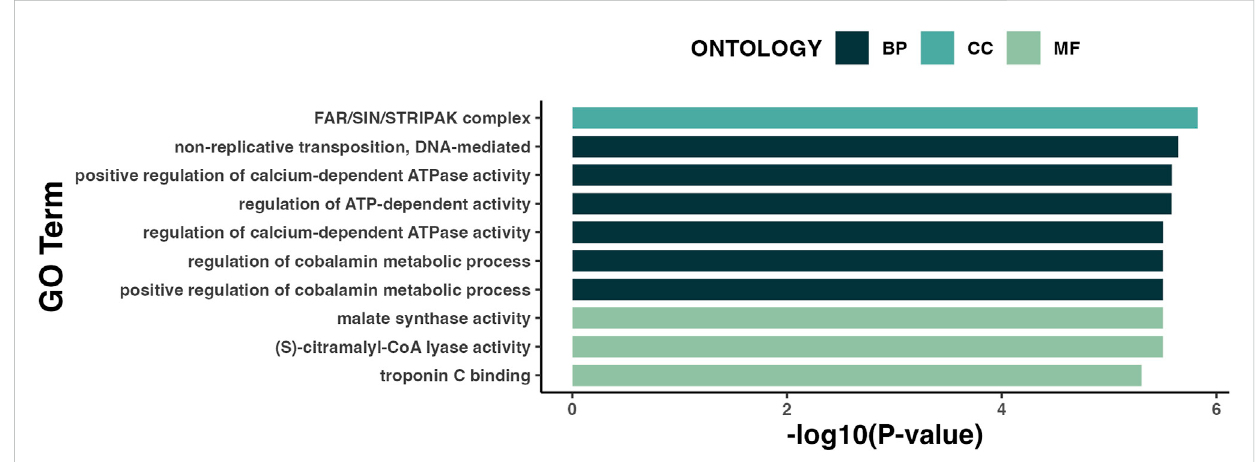
FIGURE 5 Gene-ontology (GO) pathway analysis of DML associated with SE. Results are represented in order of enrichment score [-log ( p -value)]. BP, Biological process; CC, Cellular component; MF, Molecular function.